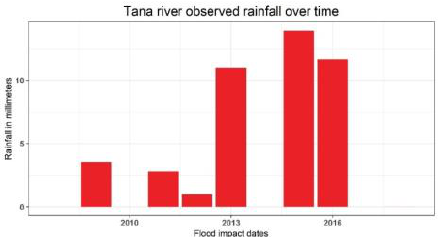
Figure 9 Tana river observed rainfall over time